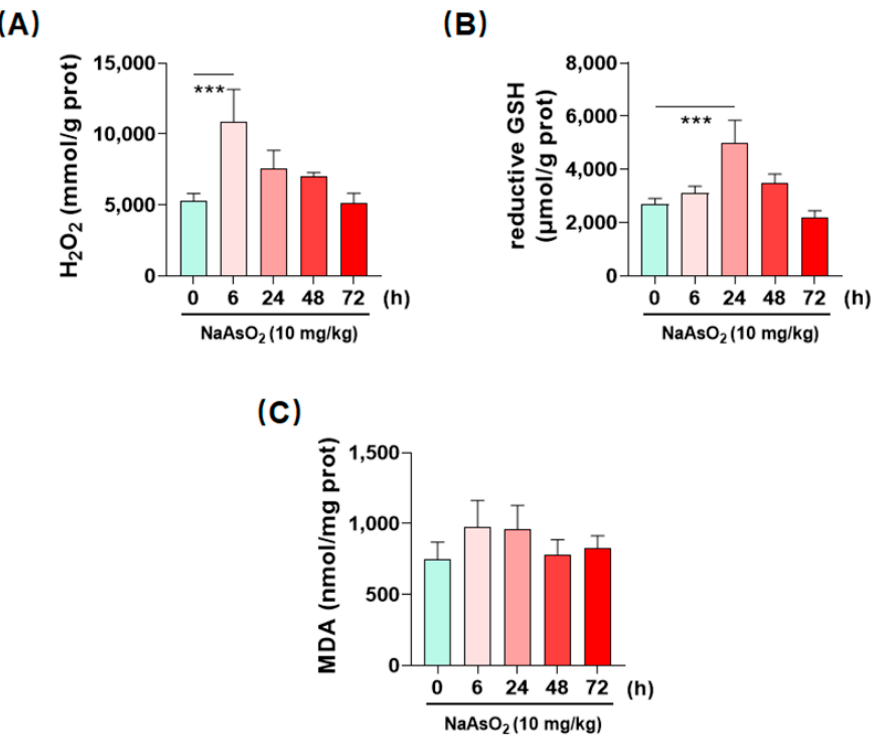
Figure 3. Imbalanced redox homeostasis in the liver of acute arsenic-exposed mice. ( A – C ) redox- related indexes H 2 O 2 , GSH and MDA in the liver were detected by biochemical kits at different time points after an oral administration of NaAsO 2 . Data are presented as mean ± SD ( n = 4). *** denotes p < 0.001 compared with Control (0 h) group.